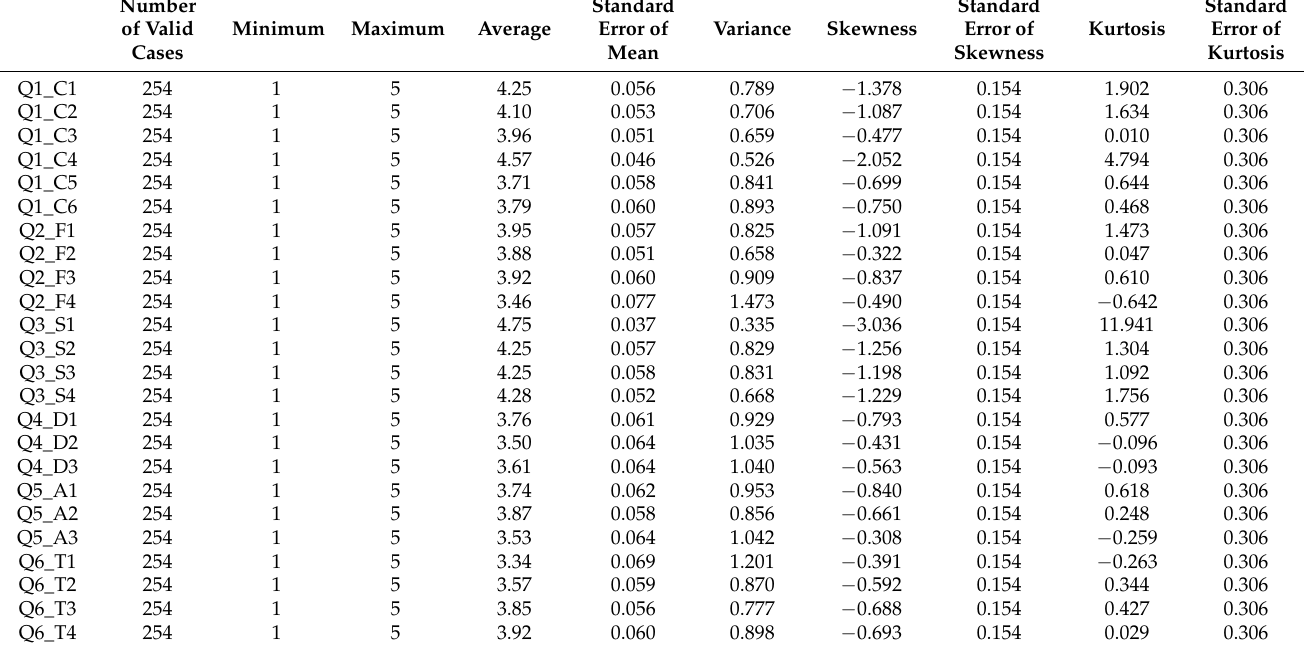
Table 4. Statistics of questionnaire